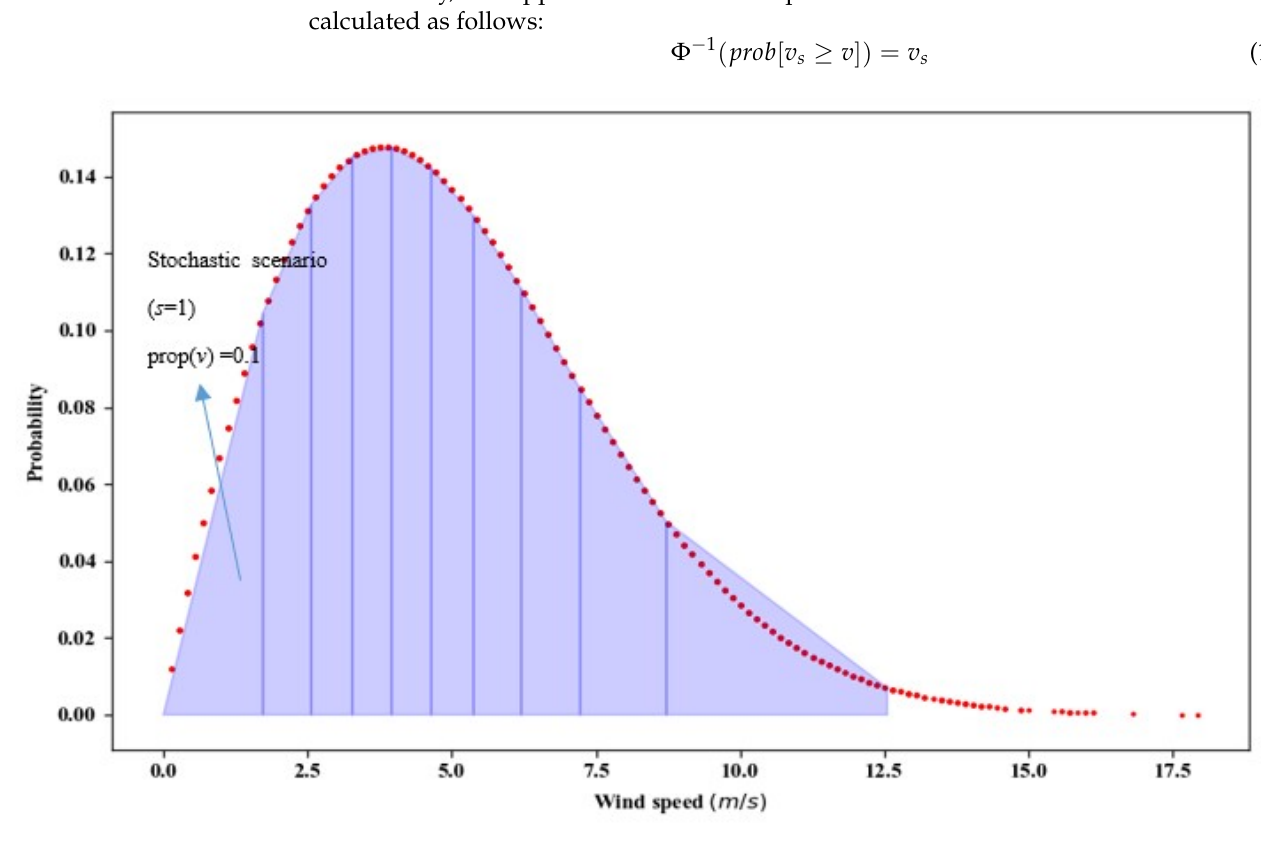
Figure 5. Wind speed stochastic scenarios.